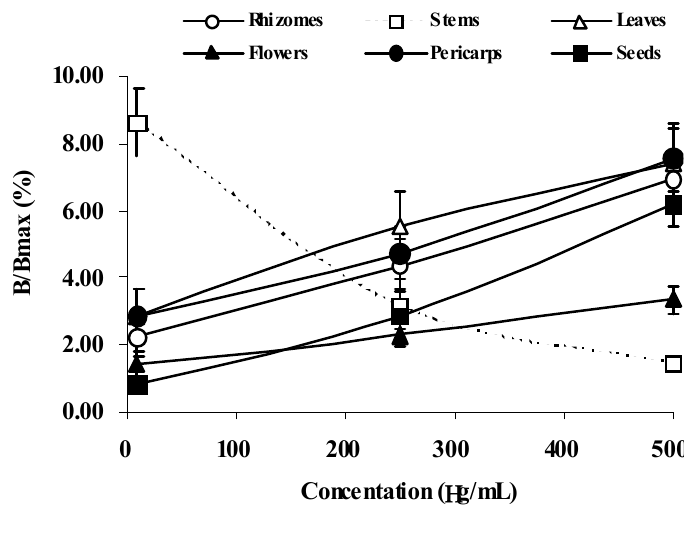
Figure 2. Dose response curve of different part extracts of A. zerumbet for estrogenic activity. Values are expressed as the mean ± SD of three replicate